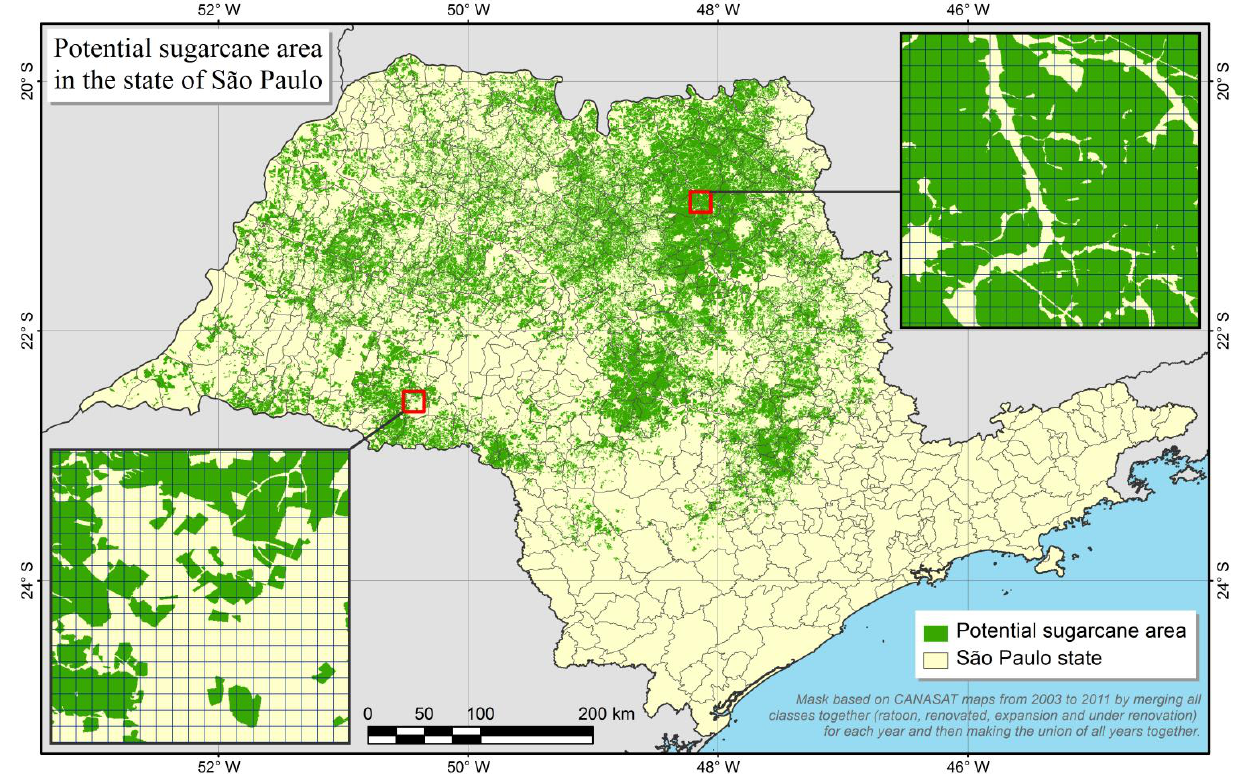
Figure 2. Sugarcane mask for São Paulo state. The grid overlaid on the two close-ups represents the spatial resolution (1 km) of the remote sensing data used in this